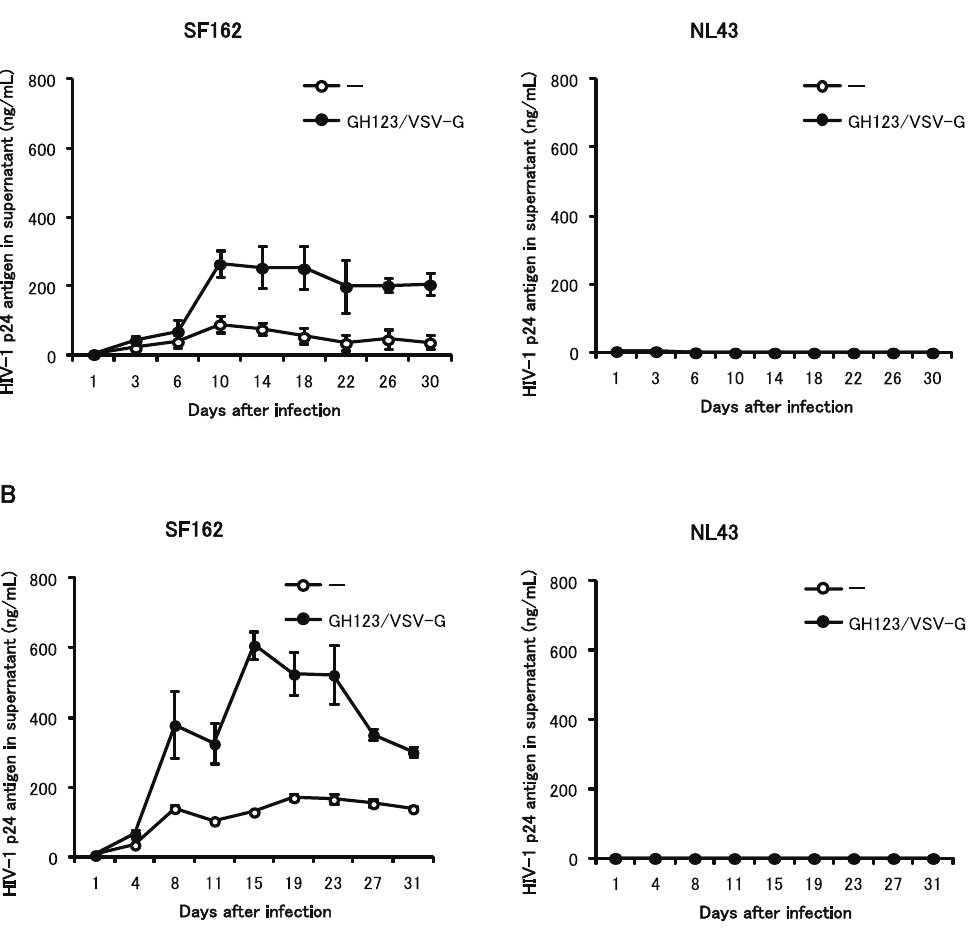
Figure 2. Effects of VSV-G-pseudotyped HIV-2 particles on macrophage-tropic and T-cell line-tropic HIV-1 strains in GM-CSF- induced macrophages. Monocytes were differentiated into macrophages for 6 days in the presence of GM-CSF. Macrophages were treated with VSV-G pseudotyped and Env-defective HIV-2 particles (GH123/VSV-G) and then infected with HIV-1 strain SF162 or NL43. HIV-1 replication was quantified by ELISA measurement of p24 antigen in the supernatant after infection. Data are plotted as the mean 6 SD of triplicate samples; presented data are representative of three independent experiments using two donors. A: Results of samples obtained from a donor 1. B: Results of samples obtained from a donor